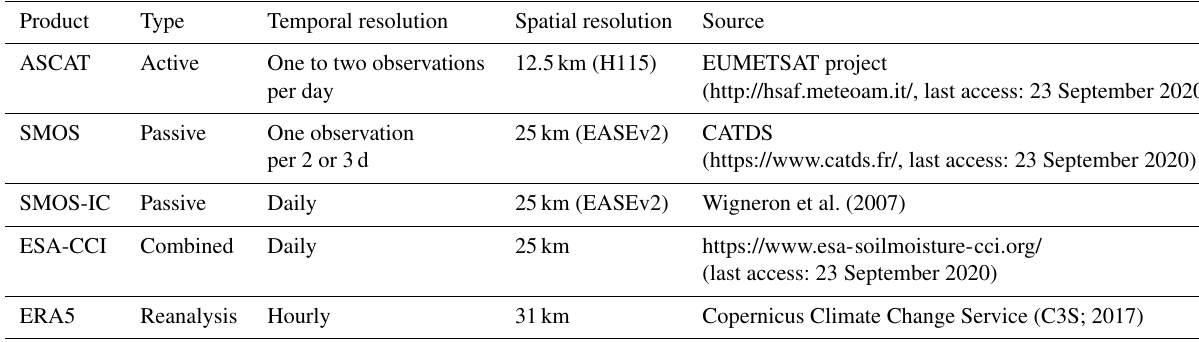
Table 3. Summary of the soil moisture products considered. Product Type